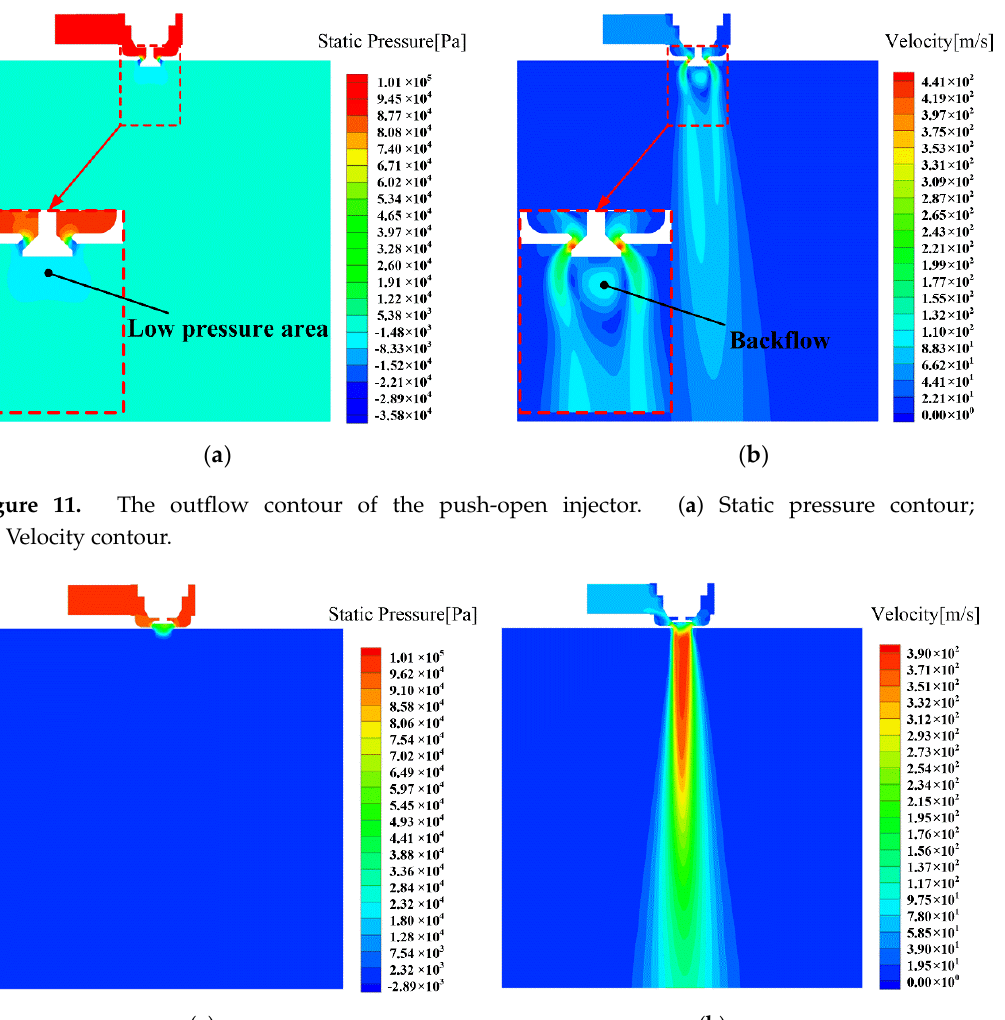
Figure 12. The outflow contour of the pull-open injector. ( a ) Static pressure contour; ( b ) Velocity contour.